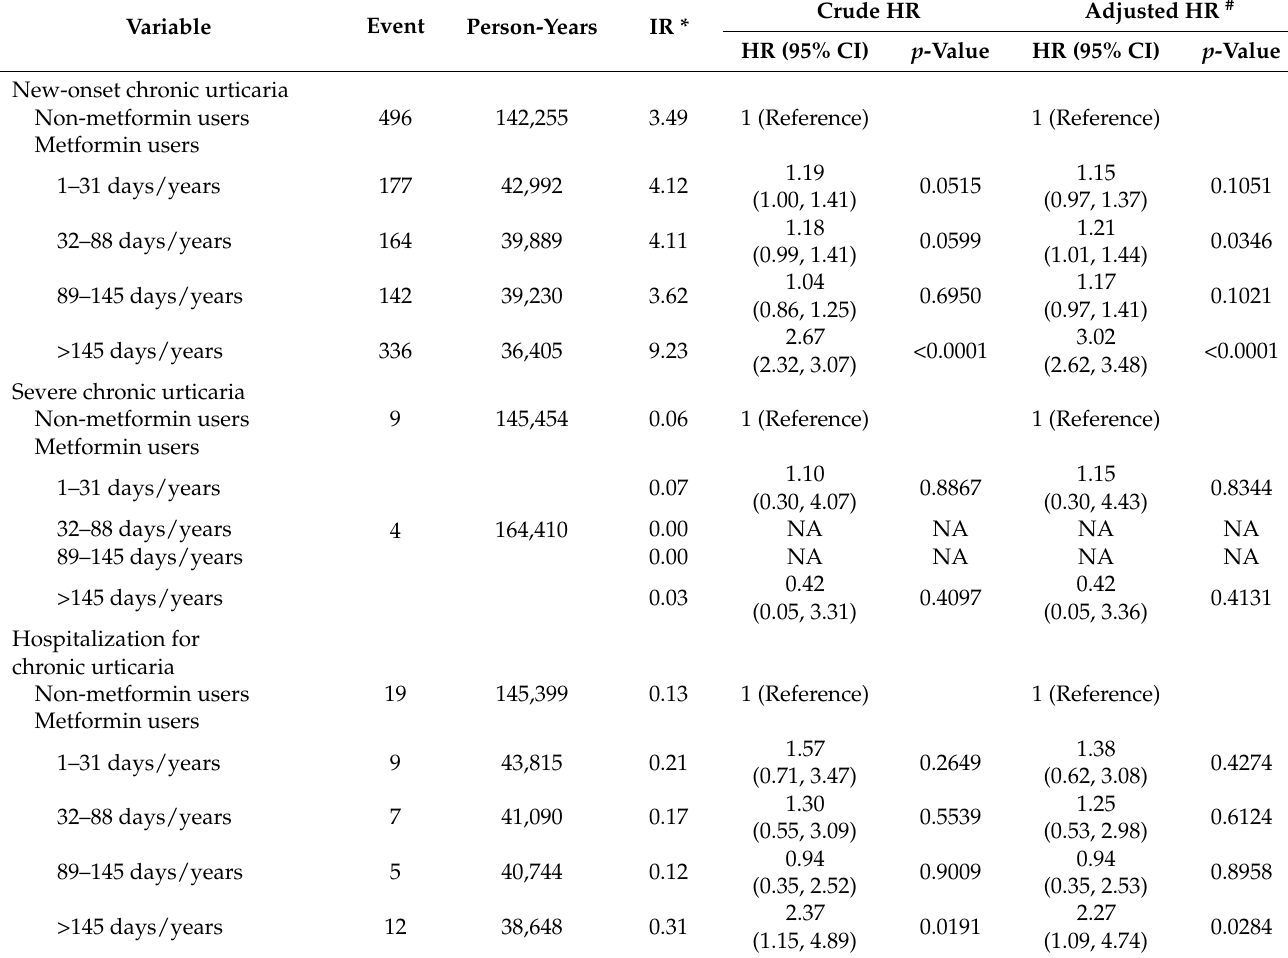
Table 3. Incidence and HRs of new-onset chronic urticaria, severe chronic urticaria, and hospitaliza- tion for chronic urticaria associated with days’ supply of metformin in T2DM